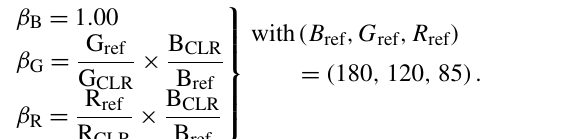
tains a solar 22 ◦ halo, and the other one is a partly cloudy sky without any halo